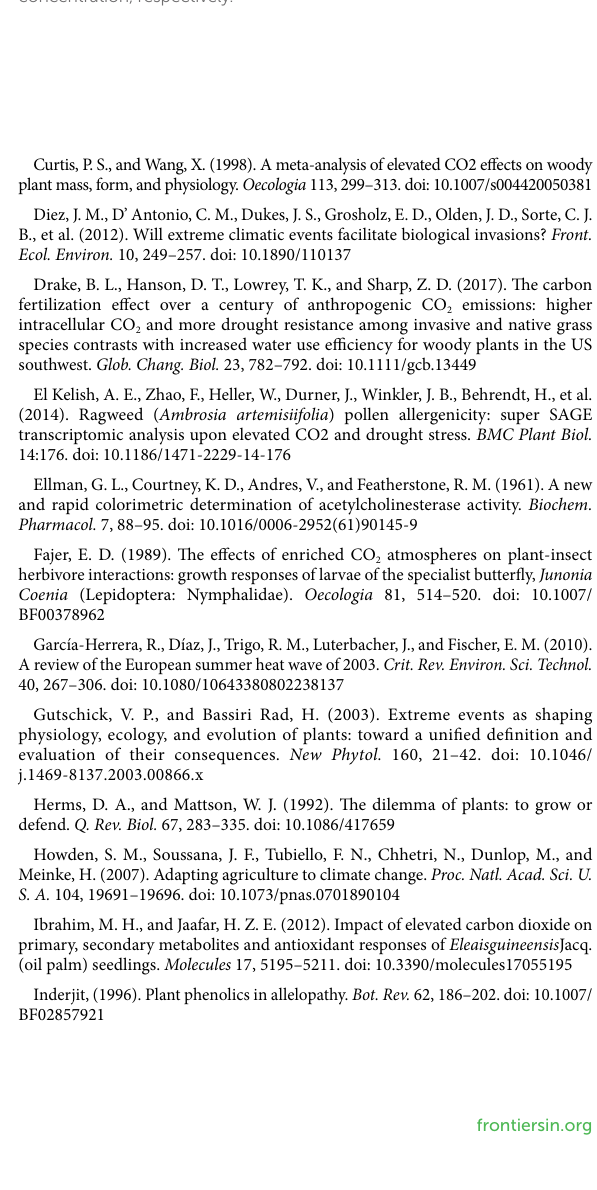
elevated atmosphere CO2 concentration and ambient atmosphere CO2 concentration, respectively. SUPPLEMENTARY FIGURE 2 Total leaf area (±SE) of Ambrosia artemisiifolia under different stress conditions. Data represented by columns bearing the same letters were not significantly different (LSD, p = 0.05). AT denotes the ambient temperature condition; HW denotes the heat wave condition. EC and AC represent elevated atmosphere CO2 concentration and ambient atmosphere CO2 concentration, respectively. SUPPLEMENTARY FIGURE 3 Plant height (±SE) of Ambrosia artemisiifolia under different stress conditions. Data represented by columns bearing the same letters were not significantly different (LSD, p = 0.05). a, b, c, d, and e represent the 1st, 2nd, 3rd, 4th, and 5th measurements, respectively. AT denotes the ambient temperature condition; HW denotes the heat wave condition. EC and AC represent elevated atmospheric CO2 concentration and ambient atmosphere CO2 concentration, respectively. SUPPLEMENTARY FIGURE 4 KEGG analysis of different metabolites between leaves of plants under AC + AT and EC + HW conditions. SUPPLEMENTARY FIGURE 5 Heatmap of different metabolites between leaves of plants under AC + AT and EC + HW conditions. CK:AC + AT; AT denotes the ambient temperature condition; HW denotes the heat wave condition. EC and AC represent elevated atmospheric CO2 concentration and ambient atmosphere CO2 concentration,